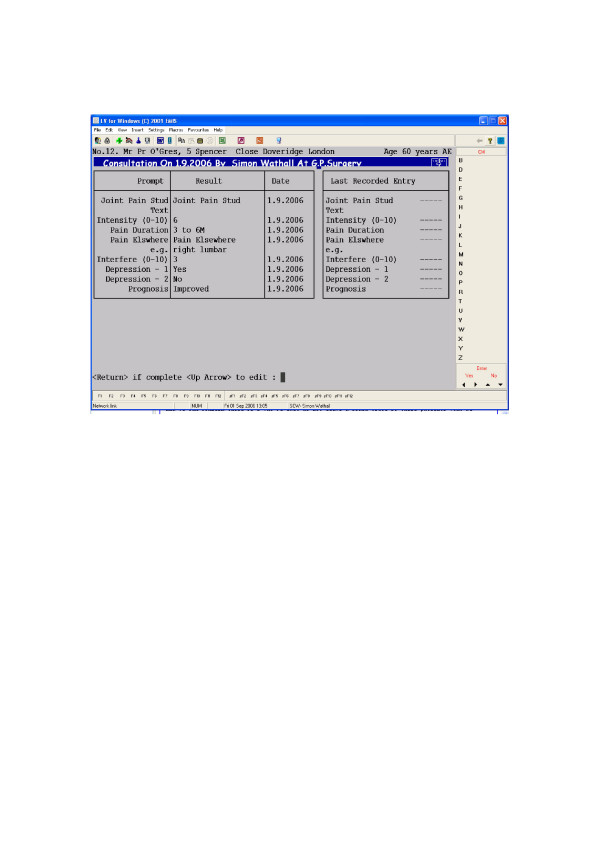
Electronic template.